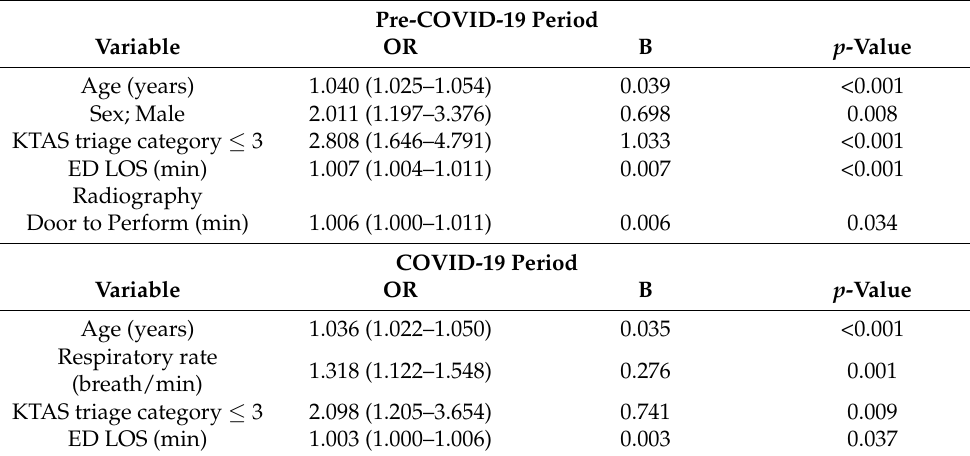
Table 5. Multivariate logistic regression analysis of admission